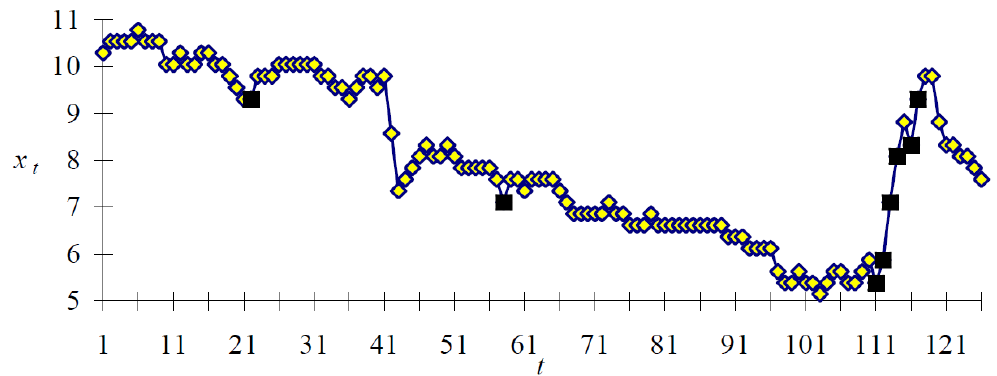
Figure 2. Financial time